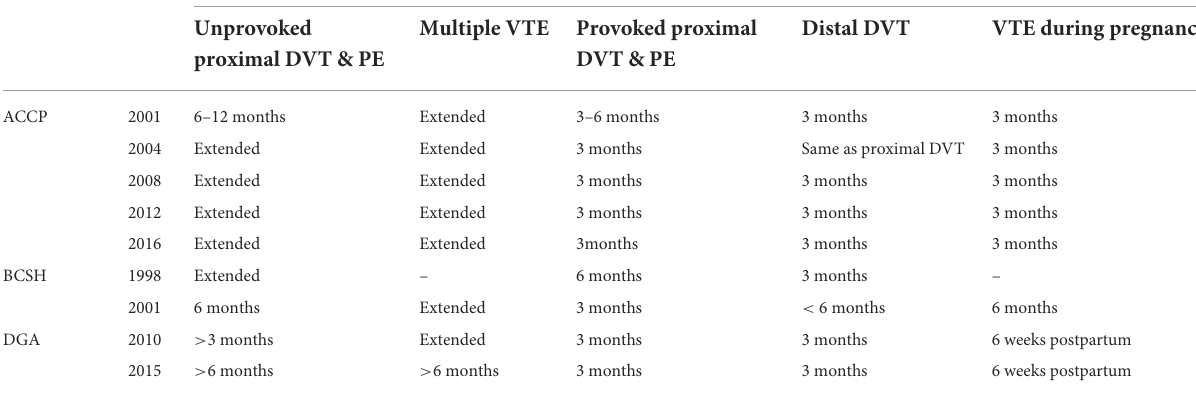
TABLE 1 Treatment recommendations in the secondary prevention of venous